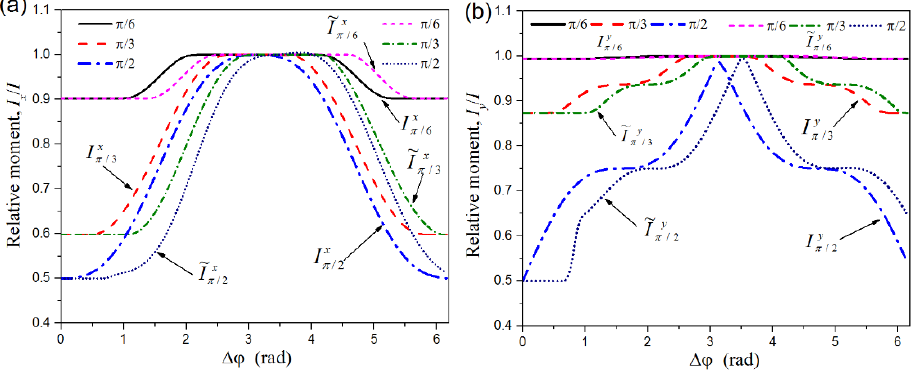
Figure 5. The moments of inertia about the rotating and fixed axes. ( a ) about X axis, ( b ) about Y axis.